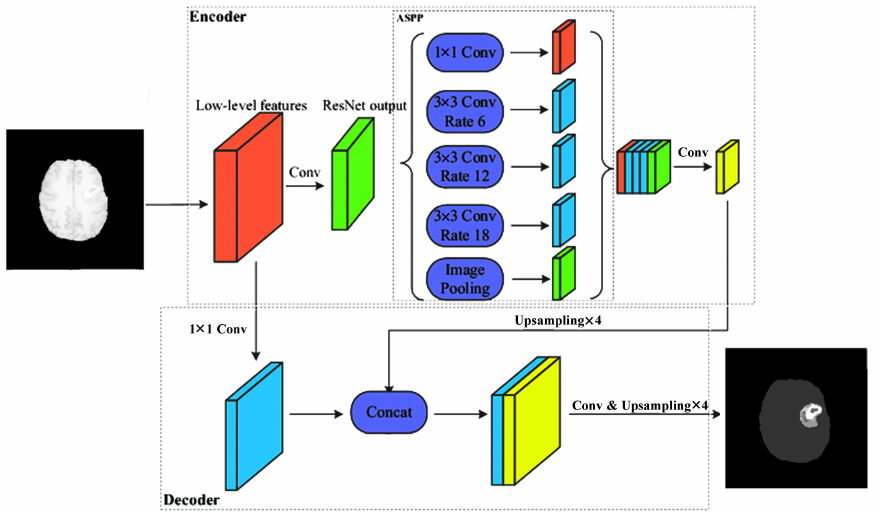
Figure 4. Adapted DeepLabv3+